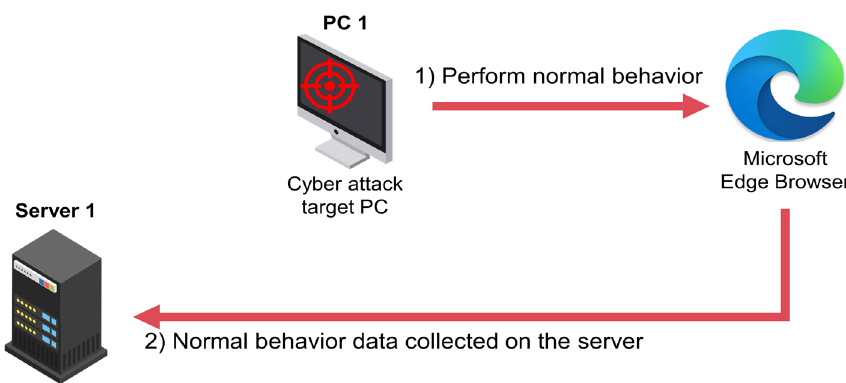
Figure 4. Normal behavior collection process.